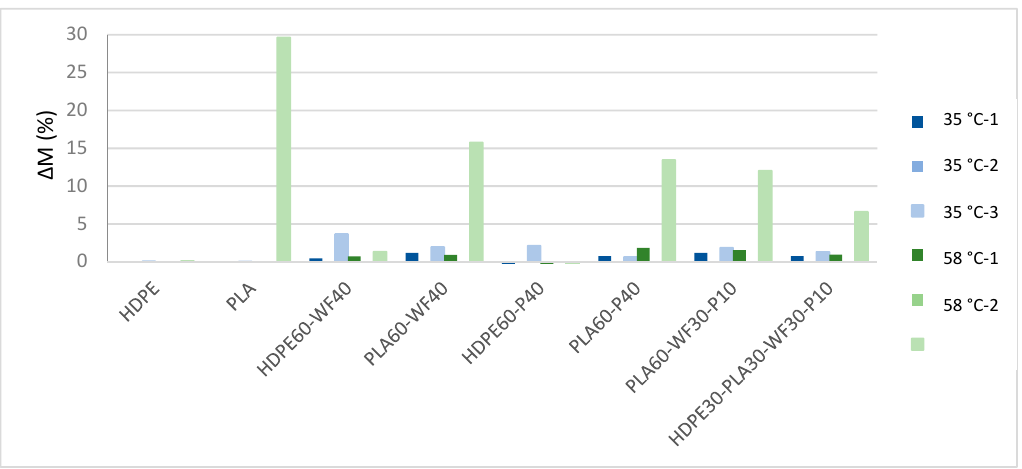
Figure 2. Mass variation measurements of HDPE, PLA, HDPE60-WF40, PLA60-WF40, HDPE60-P40, PLA60-P40 and PLA60-WF30-P10 for three months testing in soil at 35 ◦ C and 58 ◦